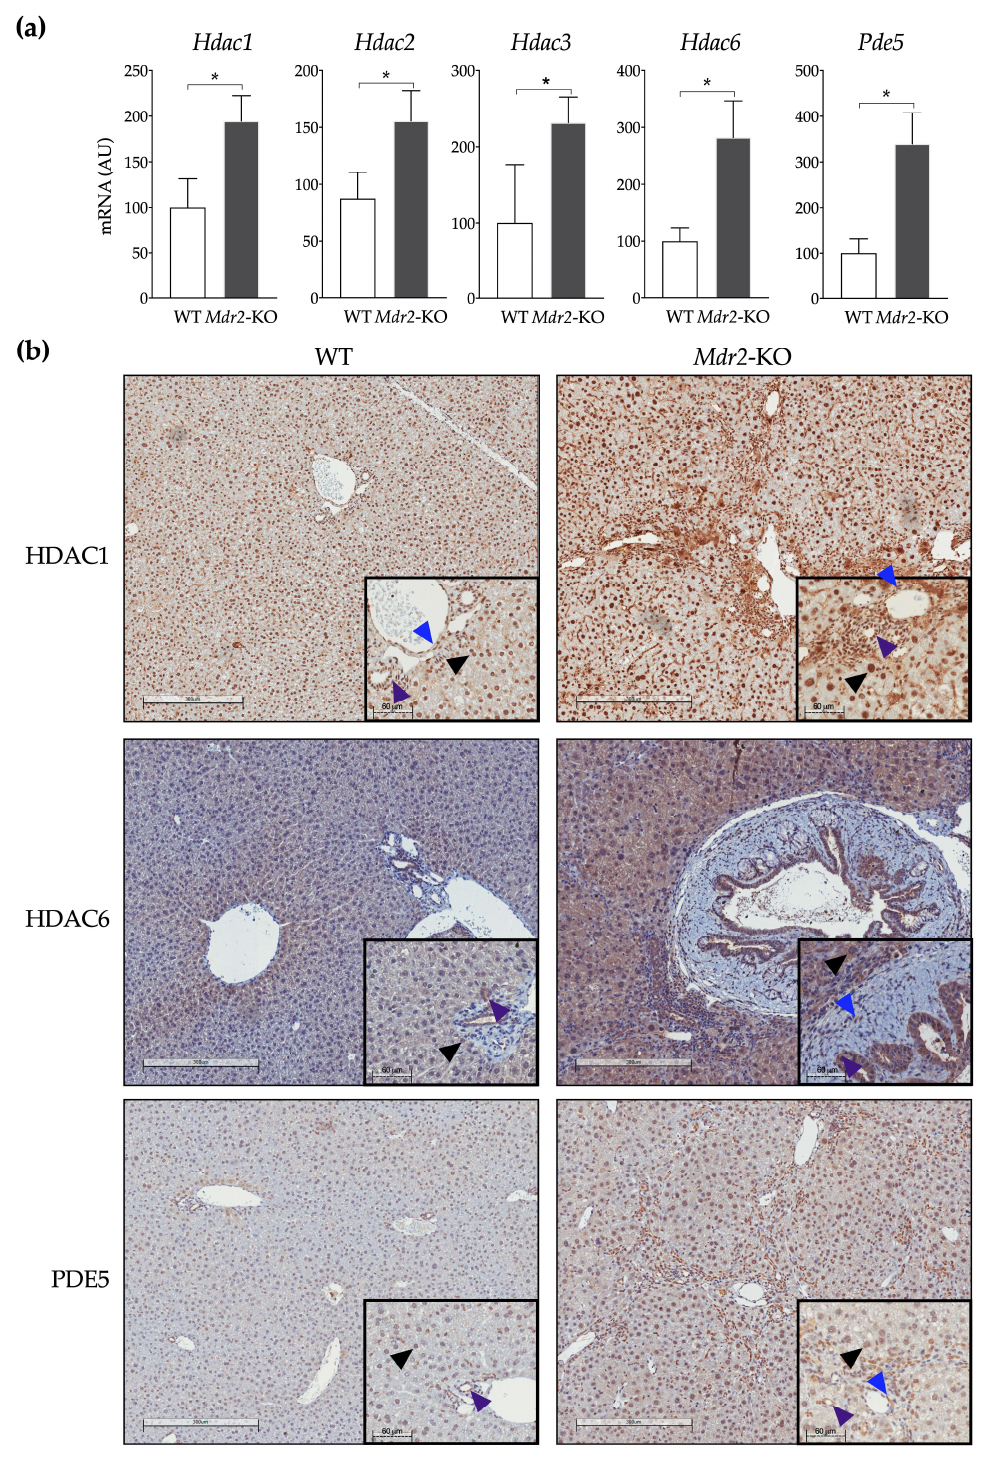
Figure 2. Expression of CM414 molecular targets in the livers of six-months old WT and Mdr2 -KO mice. ( a ) qPCR analyses of Hdac1 , Hdac2 , Hdac3 , Hdac6, and Pde5 mRNA levels. ( b ) representative images of HDAC1, HDAC6, and PDE5 immunostaining in livers from WT and Mdr2 -KO mice. Insets show enlarged areas with arrowheads indicating positive staining in hepatocytes (black), fibrogenic cells (blue), or biliary cells (purple). * p < 0.05.